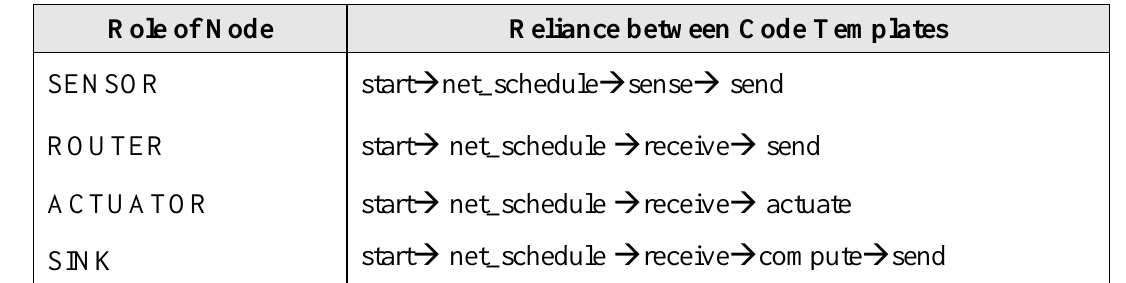
Table 5. Table on determination of reliance between templates according to the role of